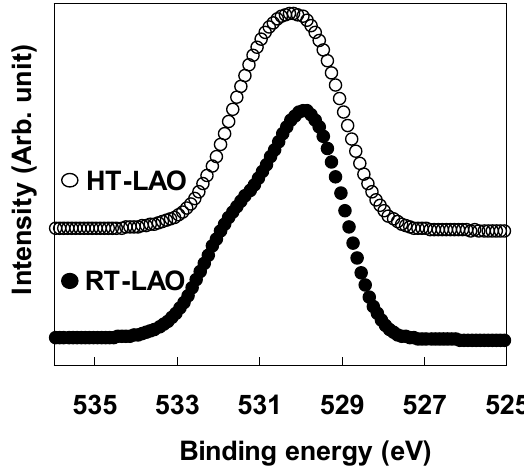
Figure 9. O 1s spectra for as-deposited RT-LAO and HT-LAO.